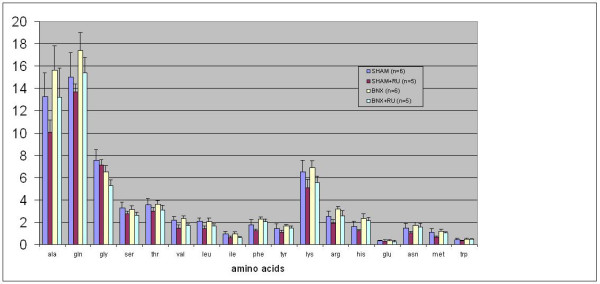
Release rate of amino acids (nmol/ min/ g muscle) from isolated perfused rat hindquarter. Error bars indicate standard deviation. The figure is based on tables 4 and 5 which give the p-values for the comparison between sham- operated and nephrectomized animals (table 4) and RU 38486 untreated and treated groups (table 5), respectively.